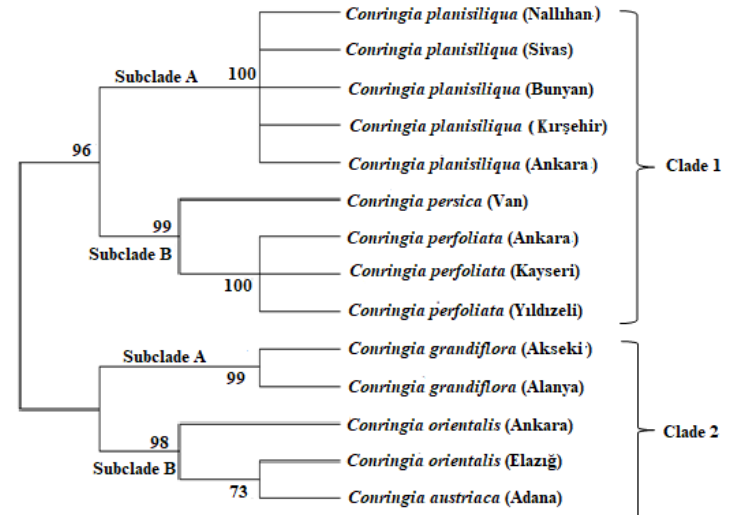
Figure 1. The Neighbour joining tree generated using nrITS sequences Conringia genus (Bootstrap values greater than 50% are given above branches)